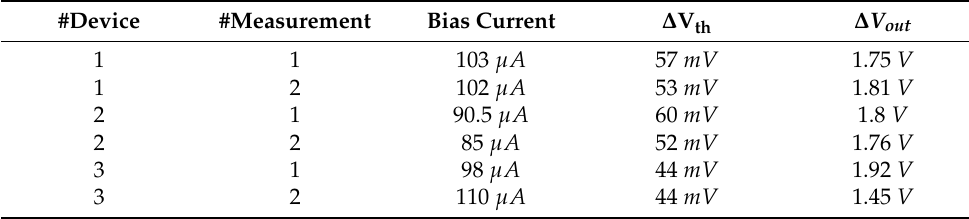
Figure 9. 𝑽 𝒐𝒖𝒕 profile during alpha radiation exposure. 𝑽 𝒐𝒖𝒕 is measured at the output of the TIA (see Figure 6a). Table 1. Summary of CMOS Sensor exposure to Alpha radiation. #Device